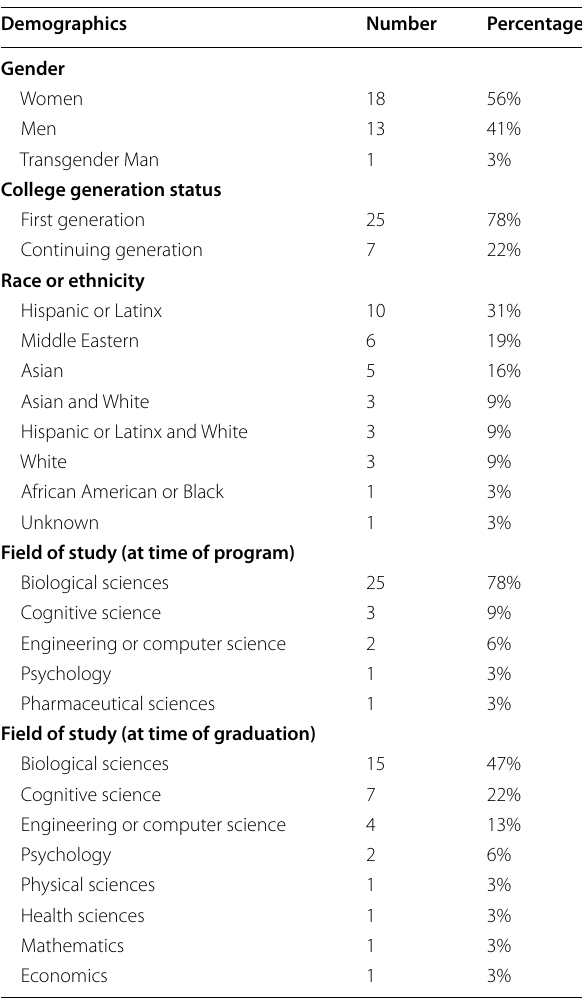
Table 1 Aggregate demographics of study participants ( n